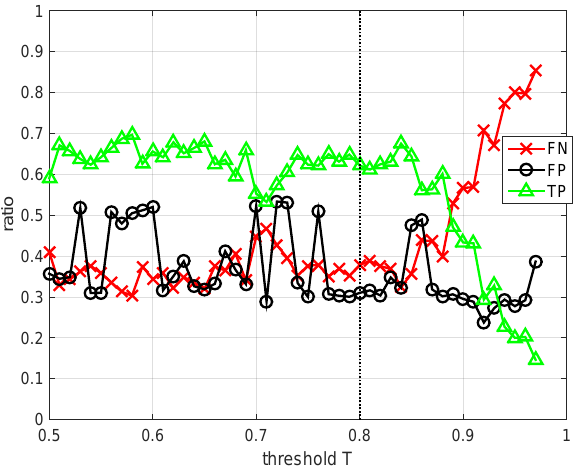
Figure 6. Influence of the threshold T on the quality of the win- dow lattice extraction result. The true positive rate (TP) is plotted in green and measures the ratio of correctly extracted windows compared to the total amount of all windows in the ground truth data. The false positive (FP) rate, black, is the ratio of extracted windows which are not in the ground truth data compared to all extracted windows. The red plotted false negative (FN) rate mea- sures the ratio of how many windows of the ground truth data are